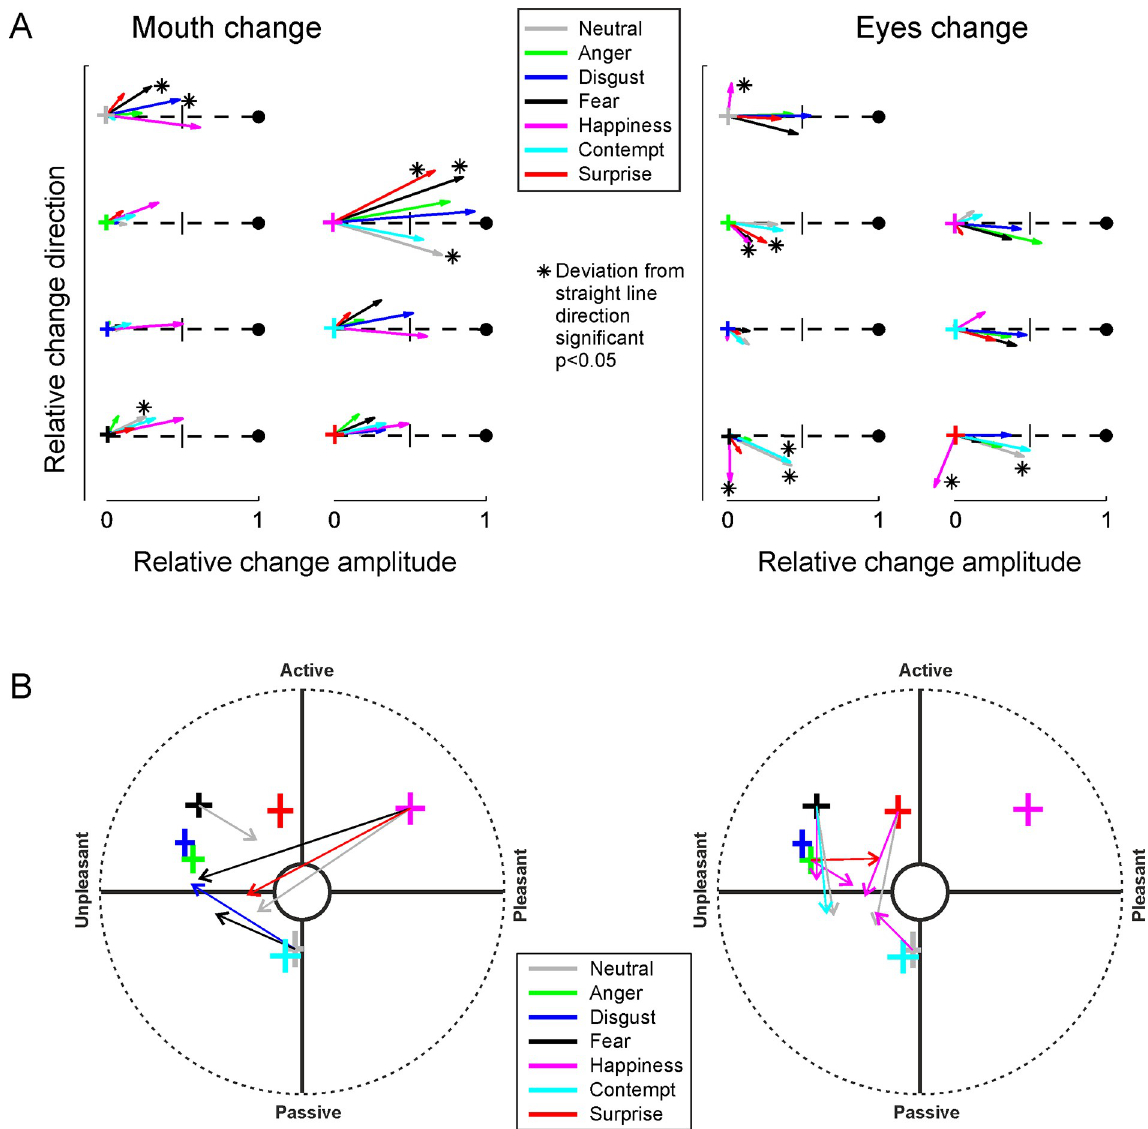
Fig 3. Shifts in perceived emotions due to incongruence. A) All shifts caused by changing the expression in the mouth region (left) or the eye region (right). The widths of the crosses indicate the 95% CIs (across participants) for the ratings of congruent expressions (see labels), the colours of the crosses indicate the congruent expression from which the mouth or eyes were changed. The arrows represent the perception shift caused by changing the eye region (left) or the mouth region (right) to that indicated by the arrow colour (see legend). The length of the arrows represents the relative magnitude of the change. An arrow that reaches the vicinity of the black circle at the end of the dashed line indicates that the percept completely followed the changed feature, an arrow that reaches the line perpendicular to the direct (dashed) path towards the centre indicates a percept based equally on both regions. Asterisks indicate shifts to directions which were of considerable magnitude but towards a direction that differs statistically significantly (t(31) > 2.9, p < 0.05 with Bonferroni correction in all tests, see Tables 1 and 2) from the direction expected based on the two emotions present in the composite faces (the dashed line). B) The unexpected shifts (indicated with asterisks in A), now presented in the V-A